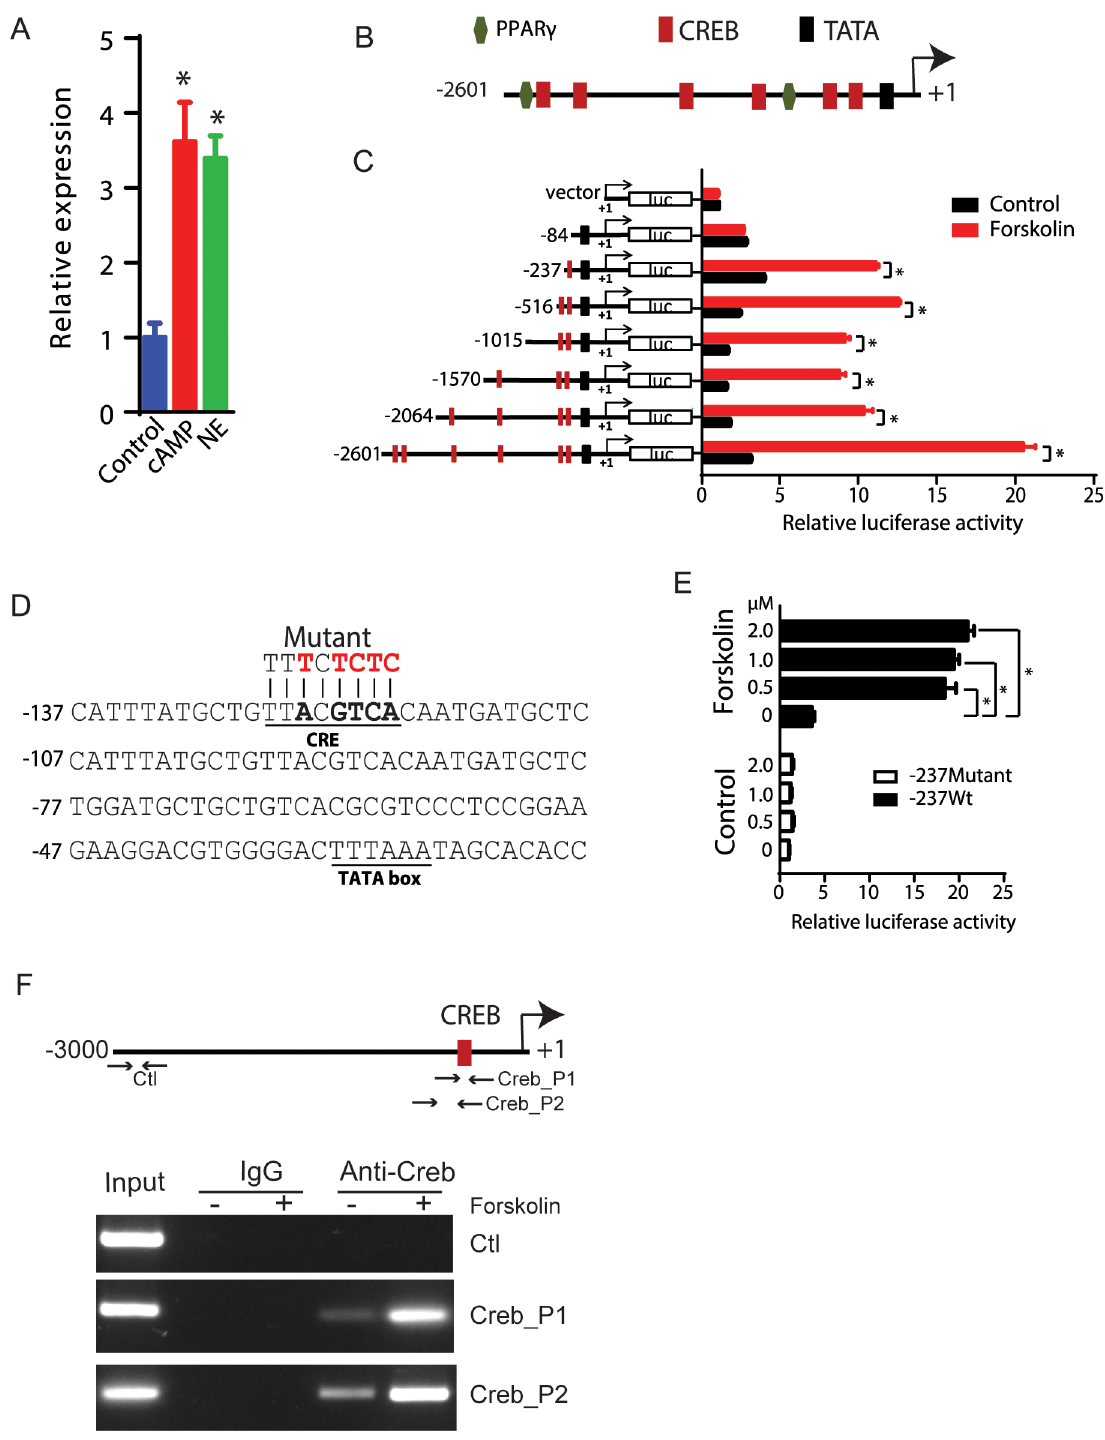
Fig 5. Transcription of brown adipose tissue–enriched lncRNA 10 (lncBATE10) is controlled by cAMP-cAMP response element-binding protein (Creb) signaling pathway. ( A )Real-timePCR analysisof the expressionof lncBATE10 in primary brown adipocytes culture treated with cAMP and norepinephrine(NE) for 4 hours. n = 3 ( B )Potentialtranscriptional factor binding sites in the lncBATE10 promoter region.Predicted by onlineprogramMatInspector (www.genomatix.de). The arrow indicatesthe transcriptionalorientation.( C ) LncBATE10 Promoter reporter assay. Promoter regionsupstream of the transcriptionalstart site of lncBATE10 with different truncations were cloned into pGL3-Basicvector. Reporterswere transfected into 293T cells. Thirty-six